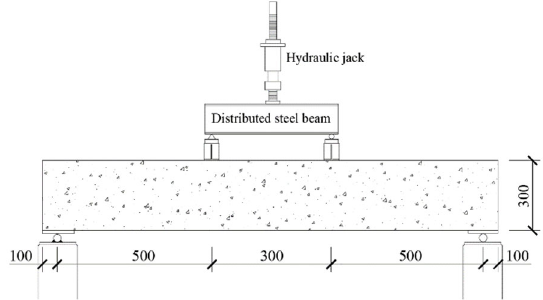
Figure 1. Loading scheme (unit: mm).